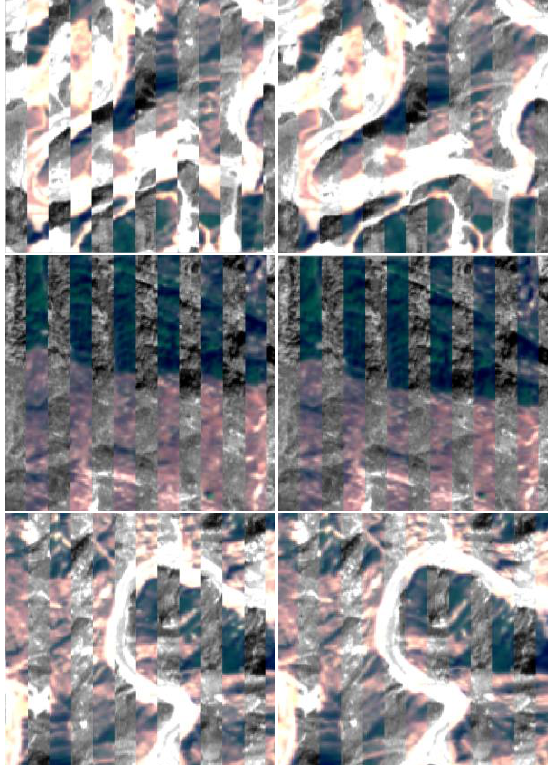
Figure 3. The left column is the rectified multispectral image overlapping on the forward panchromatic image produced by the parameterized method while the right column is produced by the non-parameterized one proposed in this study.